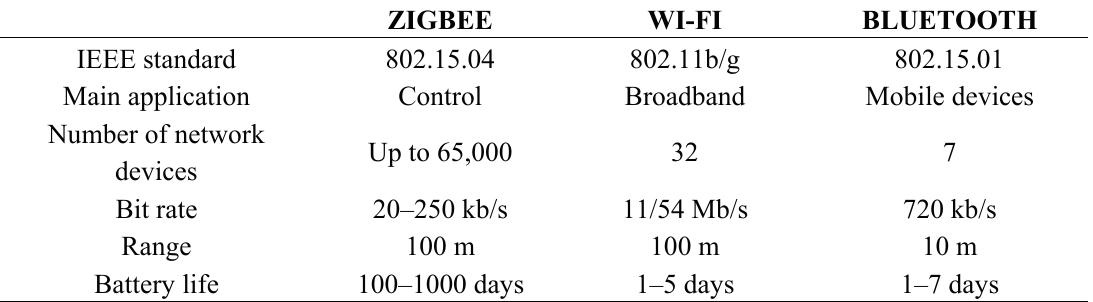
Table 1. ZigBee vs. some other wireless